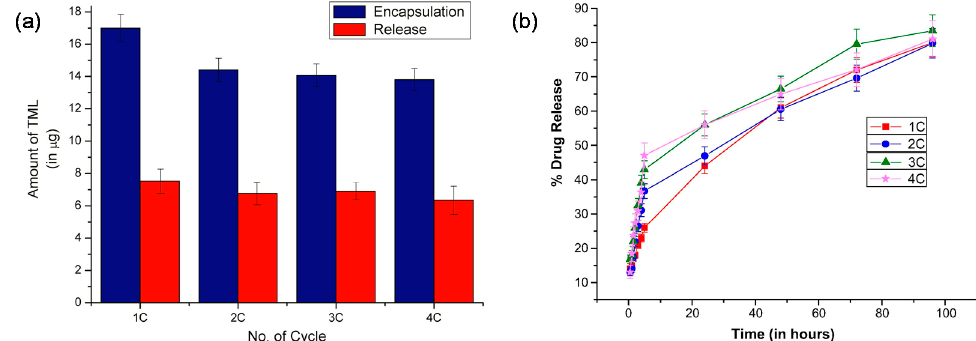
Figure 3. ( a ) Amount of timolol loaded and released after 24 h after the 1st, 2nd, 3rd and 4th cycles of drug loading. ( b ) Drug release profile after the 1st, 2nd, 3rd and 4th cycles of drug loading. Adapted with permission from Anirudhan et al. [89] .